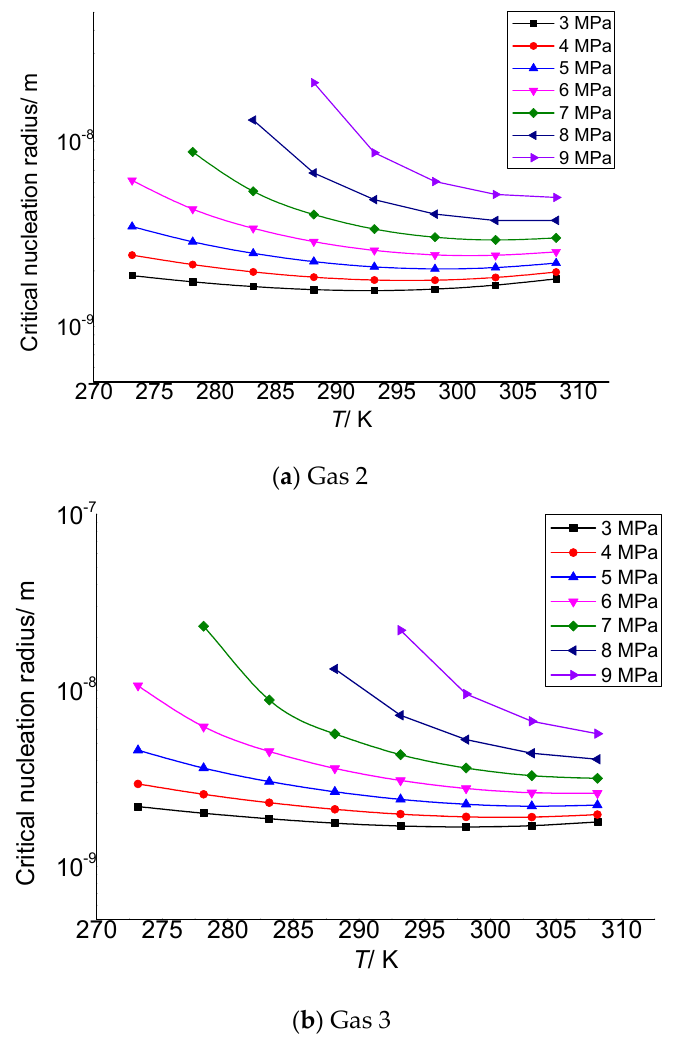
Figure 1. Curve of critical nucleation radius changing with the temperature. Tables 3 and 4 are the calculation results of the critical radius of sulfur crystal nuclei formed by supersaturated precipitation of the elemental sulfur due to pressure and tem- perature changes in gas 2 and gas 3. The molar contents of H 2 S, CO 2 and CH 4 in gas 2 in Table 3 are 2%, 5% and 93%, respectively, and the critical nucleation radius varies from 1.88 to 20.8 nm. In Table 4, the molar contents of H 2 S, CO 2 and CH 4 are 5%, 5% and 90%, respectively, and the critical nucleation radius varies from 2.18 to 23.10 nm. The data show that the initial size of the sulfur crystal nucleus is in the nanometer scale range, which is similar to the calculation results in the reference [30], indicating that the calculation results in this paper are